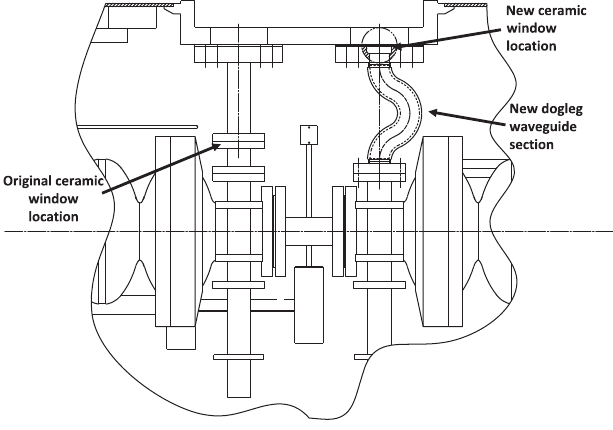
FIG. 20. rf window relocation and dogleg waveguide in C50 cryomodules.